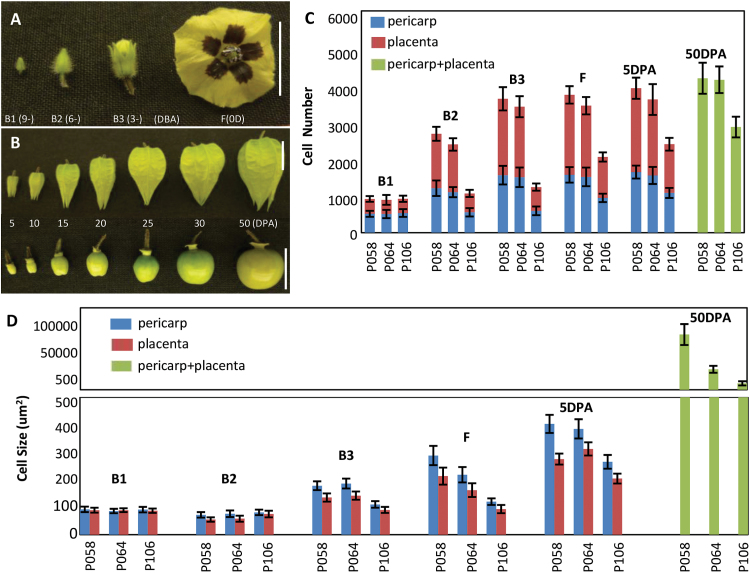
Berry development in Physalis species. (A) Flower development. The developmental stage of the mature flower (F) was set as d 0, and the floral buds at 9 (B1), 6 (B2), and 3 (B3) d before anthesis (DBA) are presented. (B) Fruit development. The developing berries of 5, 10, 15, 20, 25, 30, and 50 DPA are presented. The top images are intact fruits, and the bottom images represent the berries in which the inflated calyx was removed. The developmental stages in P. philadelphica were similarly defined for harvesting of tissues. Bars, 1cm. (C) Cell number variation. (D) Cell size variation. Quantification was performed according to median transverse section of the developing carpel and fruit from the floral buds (B1, B2, and B3), mature flower (F) and the developing berries of 5 and 50 DPA (see Materials and Methods for details). Five median transverse sections for each stage sample were analysed. The cell size of 150 cells for each tissue on each section was measured. The cell number for each section was counted. The mean and standard deviation are presented. The details are presented in Tables S3 and S4.